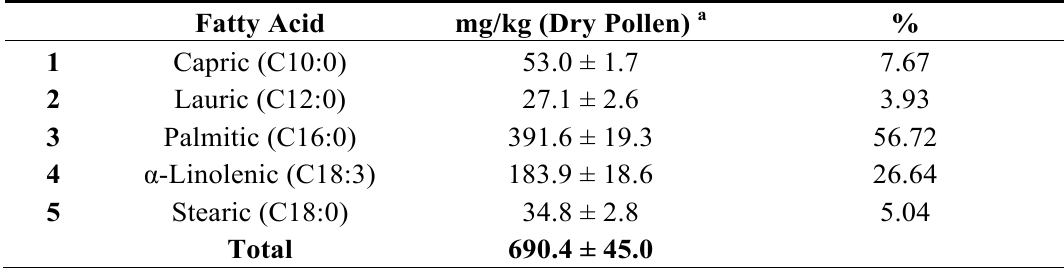
Table 2. Fatty acids composition of E. plantagineum bee